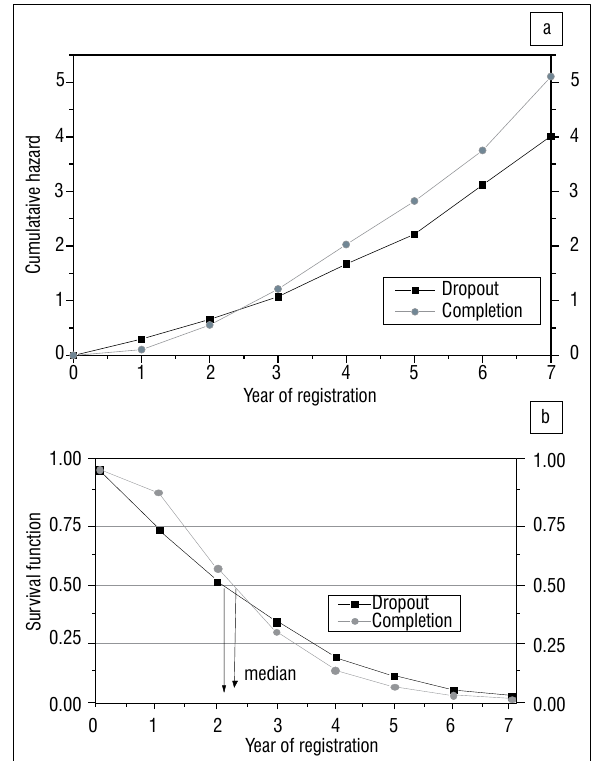
Figure 3: (a) Cumulative hazard and (b) survival functions for master’s students who graduated or dropped out of study at University of KwaZulu-Natal.